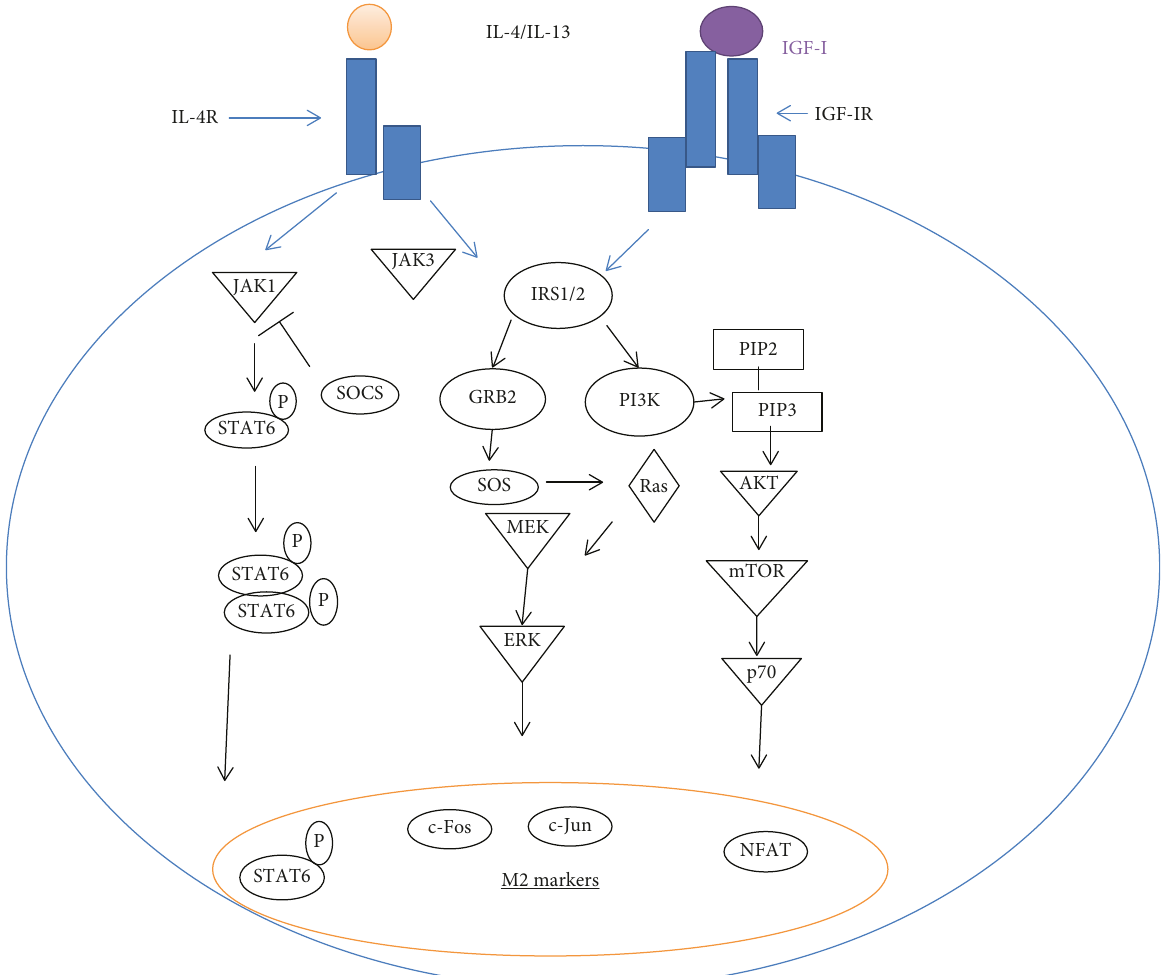
Figure 6: Scheme of the common components of the IGF-I and IL-4 signaling